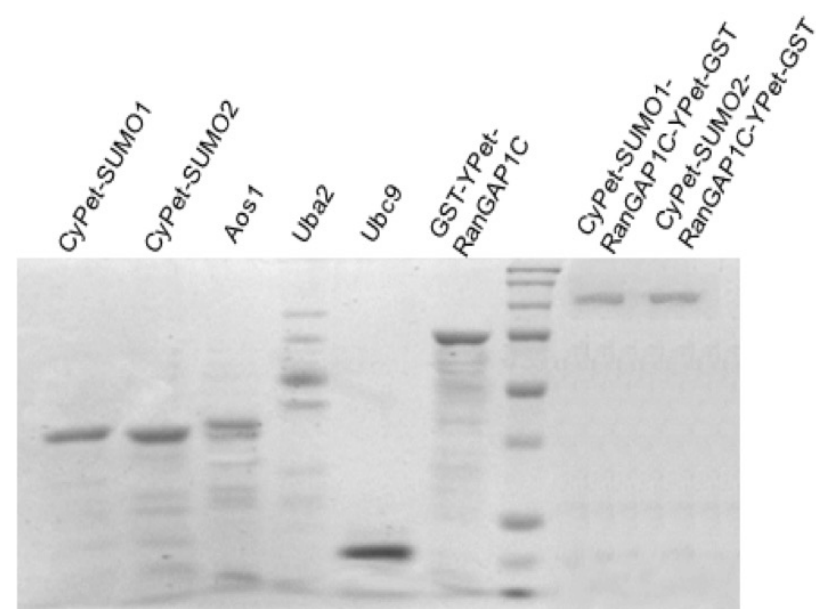
Figure 3. Coomassie staining of purified proteins in SUMO conjugation assay. From left to right: CyPet-SUMO1 (~40 kD) CyPet-SUMO2 (~40 kD), Aos1 (~38 kD), Uba2 (~65 kD), Ubc9 (~22 kD), GST-YPet-RanGAP1C (~75 kD), protein marker, CyPet-SUMO1-RanGAP1C-YPet-GST (~113 kD), and CyPet-SUMO2-RanGAP1C-YPet-GST (~113